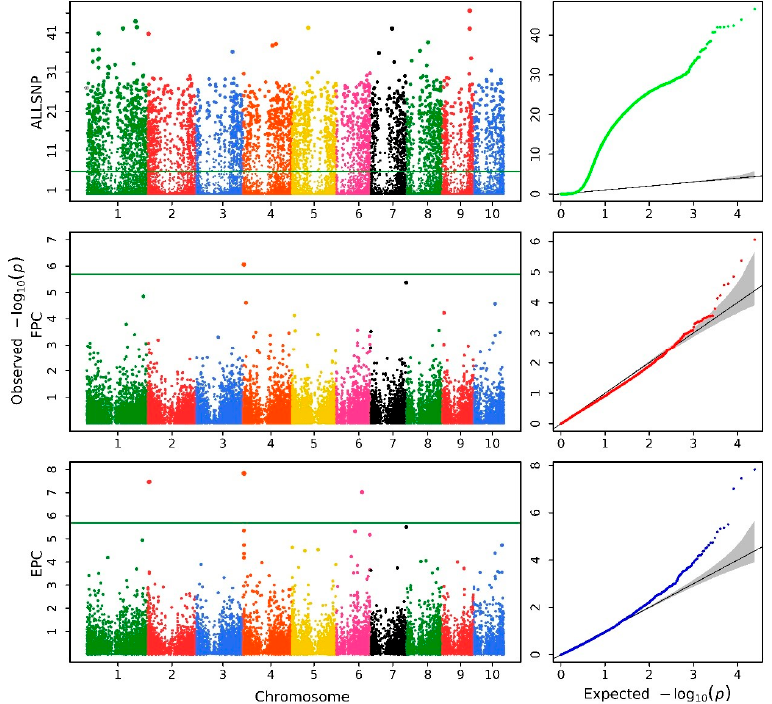
Figure 5. Manhattan plots ( left ) and Q-Q plots ( right ) for the C22:0/C24:0 trait of HAU maize.